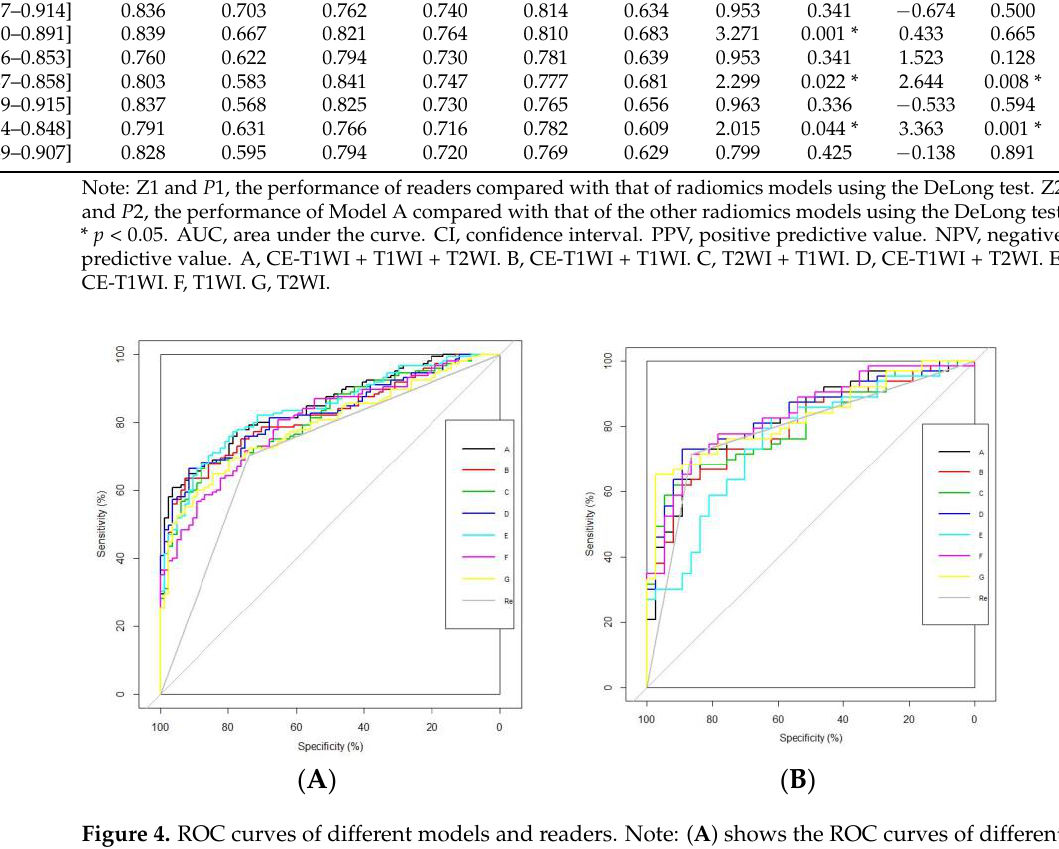
Table 4. The performance of 7 radiomics models in staging NPC.